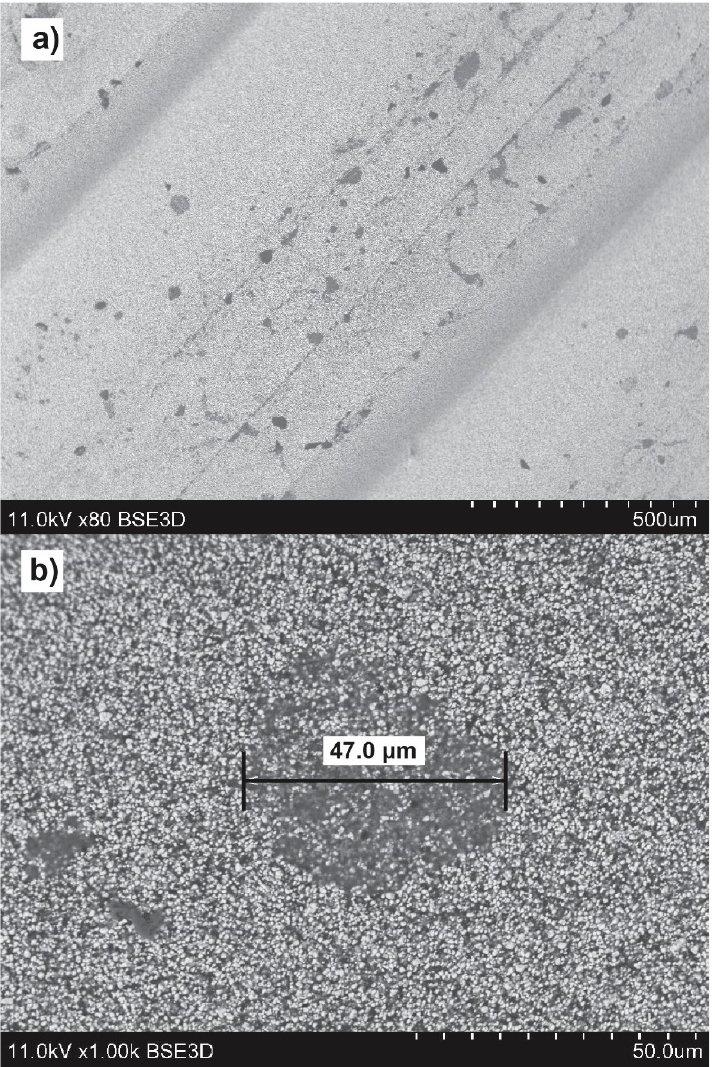
Figure 8. Backscattered electron micrographs of the surface of a 3D-printed layer of ABSc at 80× ( a ) and 1000× ( b ) magnification showing large areas of isotropically distributed barium titanate particles (white dots). Small (<50 µm) voids are visible on the surface. At 1000× magnification, individual BaTiO 3 particles are visible and are less densely distributed inside the void.